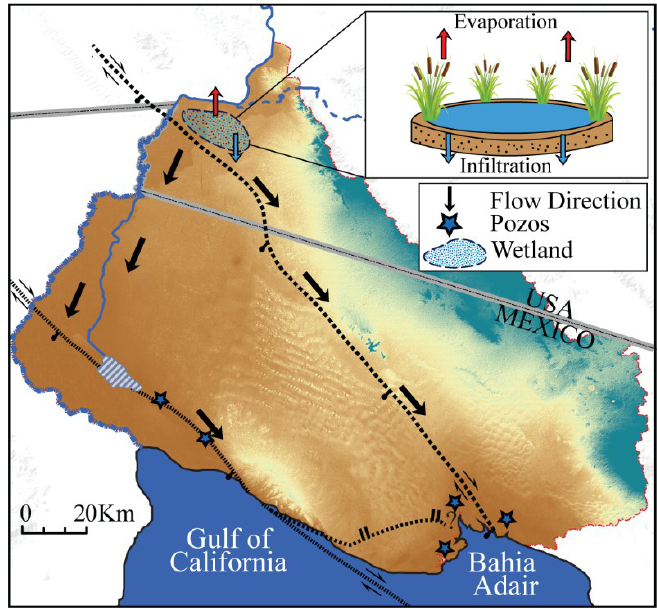
Figure 13. Schematic diagram showing recharge mechanisms. Recharge to the pozos was subjected to an evaporative process in a wetland environment prior to infiltration. Groundwater then followed a preferential flow path along the major faults in the